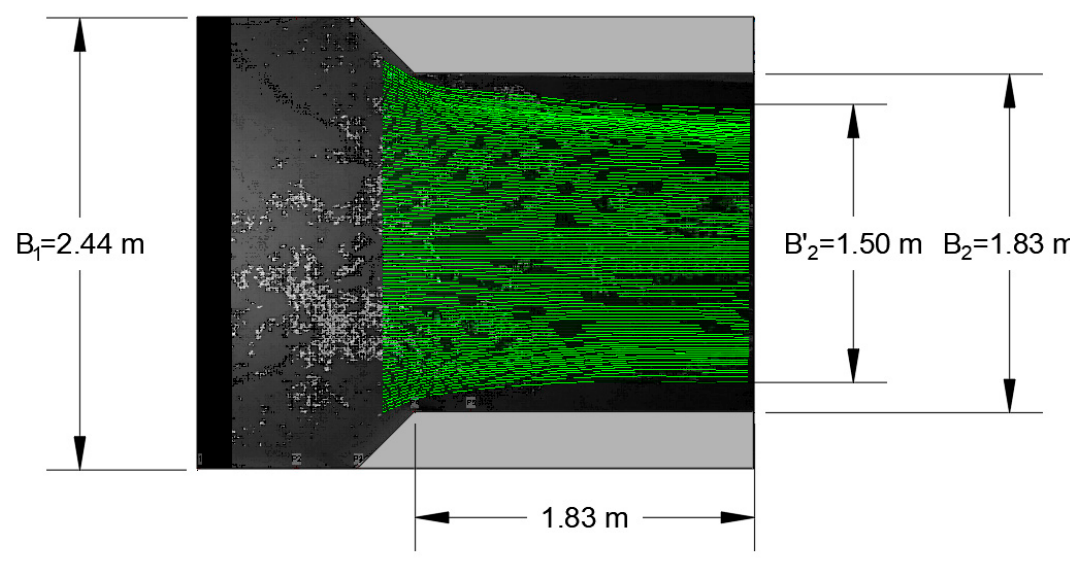
Figure 19. The measured value of vena contracta width B’ 2 obtained for experiment with B 2 /B 1 = 0.75 and discharge of 0.099 m 3 /s.